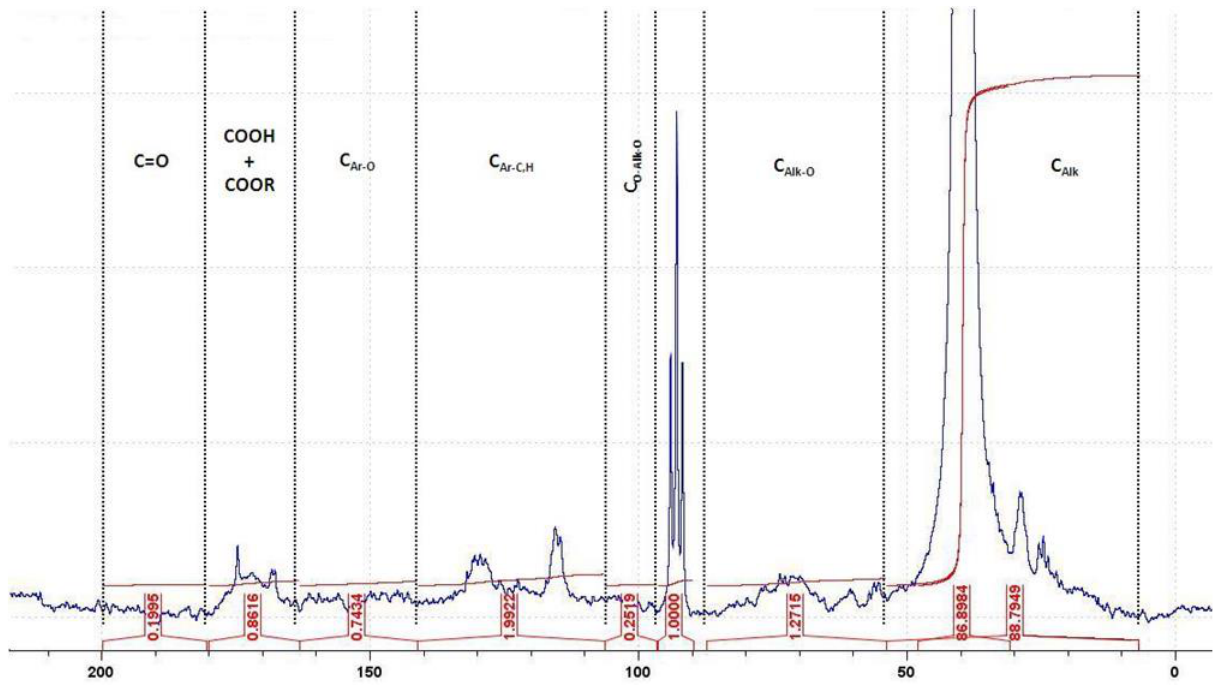
Figure A2. 13 C-NMR spectrum of fulvic acids in